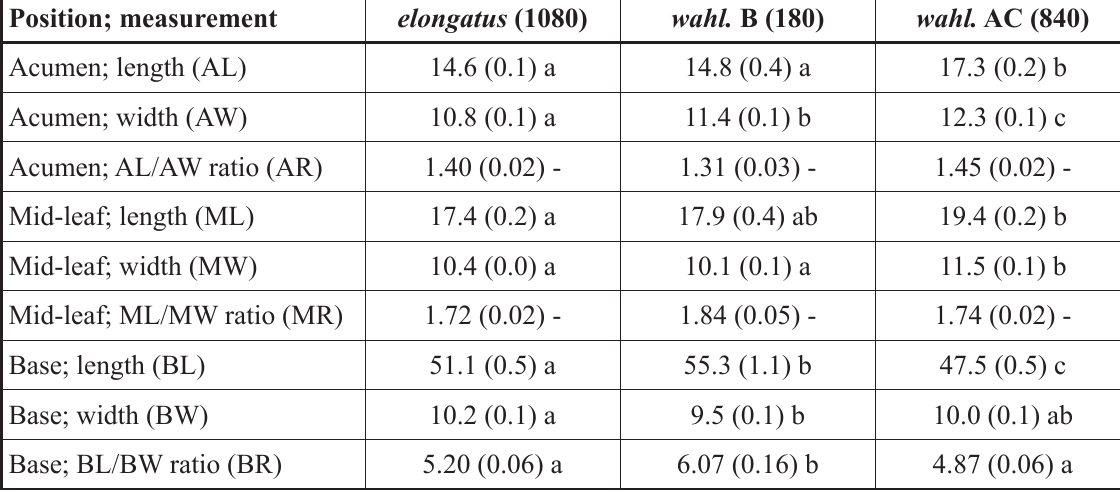
Table 2. Means plus standard errors for cell measurements in the acumen (20 cells per leaf), in mid-leaf (20), and in the sheathing base (20) from three leaves in each of 18 specimens of Oncophorus elongatus , three specimens of O. wahlenbergii B, and 14 specimens of O. wahlenbergii A and C (AC). The number of measured cells at each position, n, is indicated after the species. Significant pair-wise differences between species revealed by the Kruskal-Wallis test are indicated by different letters appended after the values in the respective columns, for the Bonferroni corrected p values corresponding with p < 0.05.